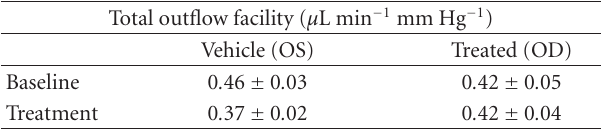
Table 3: Comparison of the e ff ect of timolol (0.5%) and